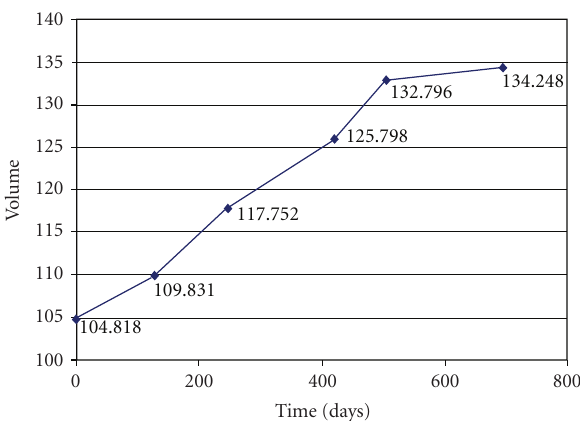
Figure 36: Patient 3. Evolution of the tumor with respect to